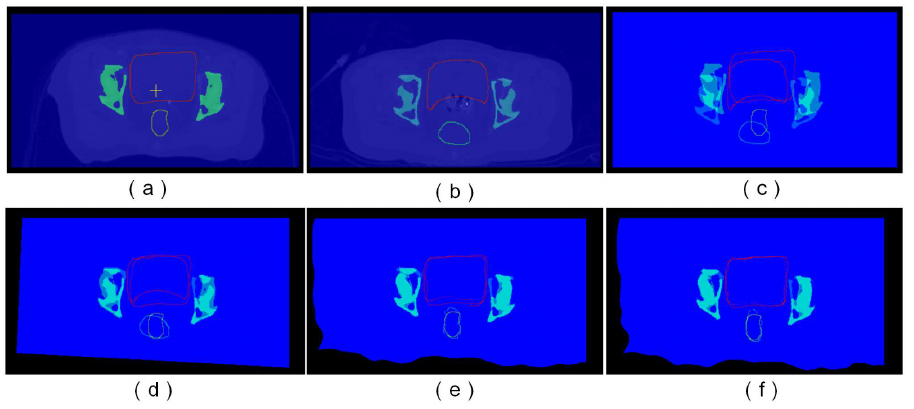
Fig 11. Validation of alignment of images by mapping contours of important organs. The contours of the pelvis, bladder,and rectum are delineatedby an expert on both EBRT (a) and HDR-BT images (b). Alignment of both contours images without registration(c), and after affine (d), FFD (e), and LFFD+FFD registration